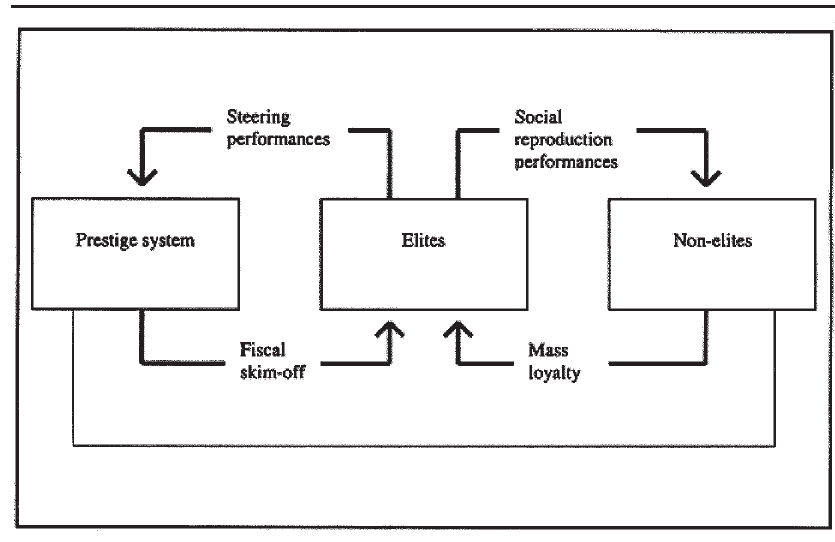
Figure 1 – Habermas’s Conception of Capitalist Sociopolitical Organization Figure 2 – Perigrine’s Revision Of Habermas, Emphasizing Social Reproduction in a Prestige